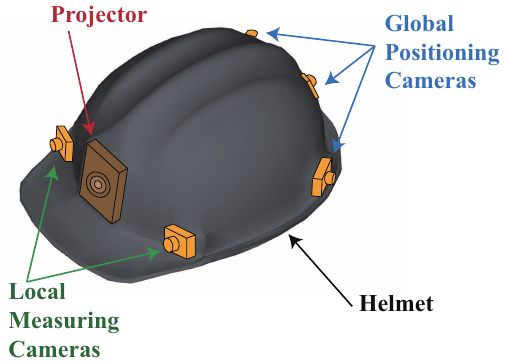
Figure 1. Immersive positioning and measuring